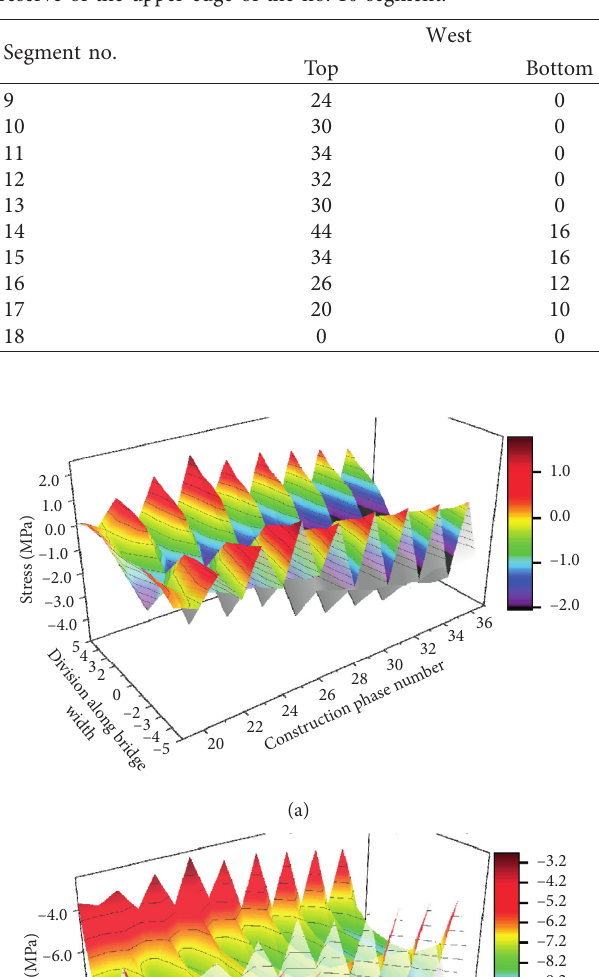
Table 6: Efficacy promotion of the new techniques applied in the Shatuo Bridge (unit: